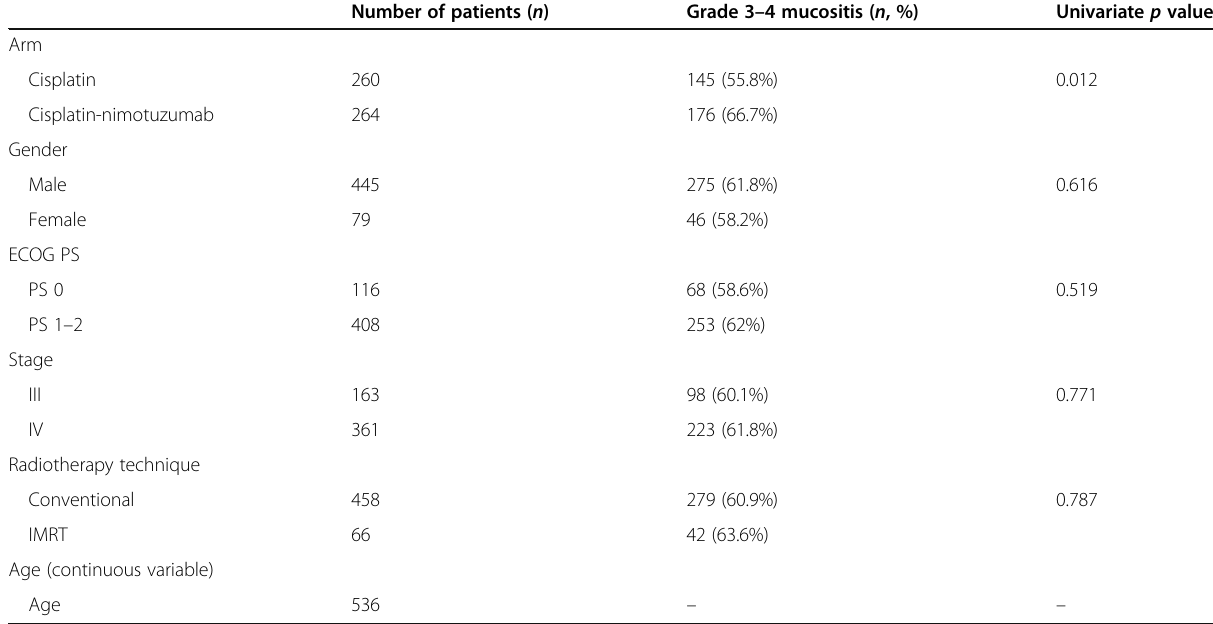
Table 2 Factors affecting grade 3 – 4 oral